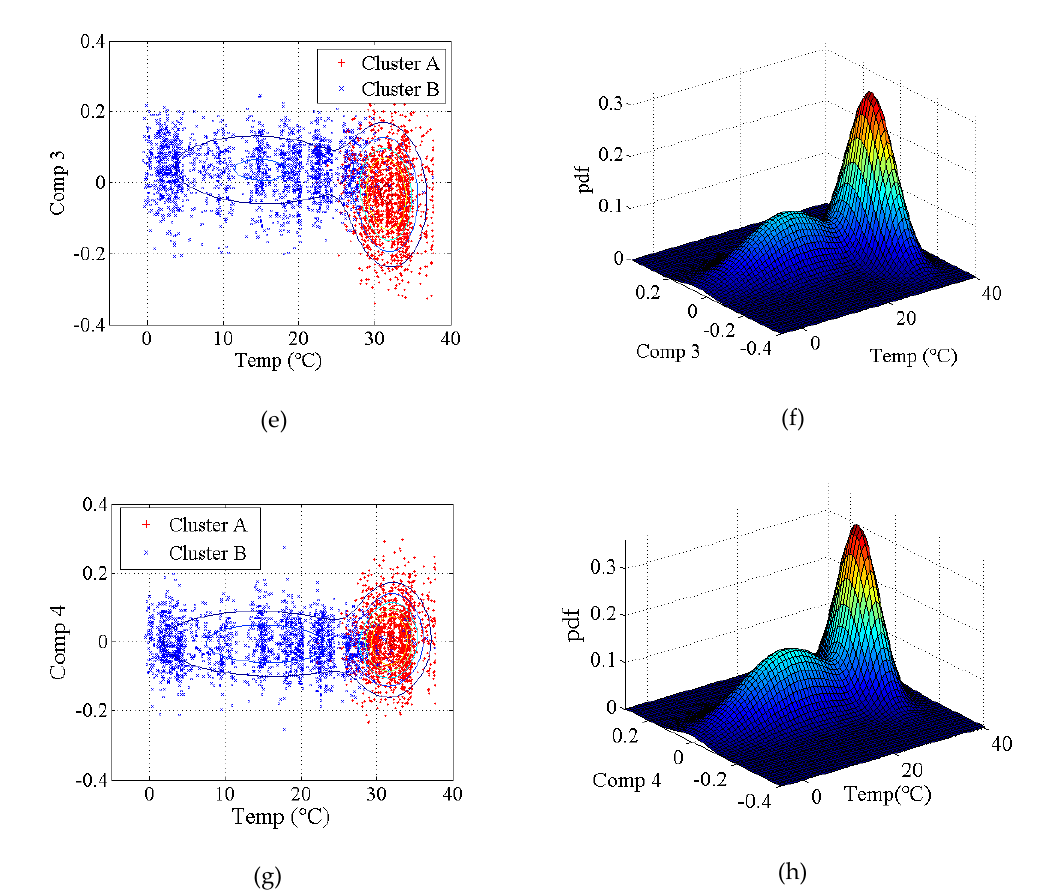
Figure 18. Results of the cluster analysis of principal components for an actual bridge: ( a ) two-dimensional results of the first principal component; ( b ) three-dimensional results of the first principal component; ( c ) two-dimensional results of the second principal component; ( d ) three-dimensional results of the second principal component; ( e ) two-dimensional results of the third principal component; ( f ) three-dimensional results of the third principal component; ( g ) two-dimensional results of the fourth principal component; ( h ) three-dimensional results of the fourth principal component.